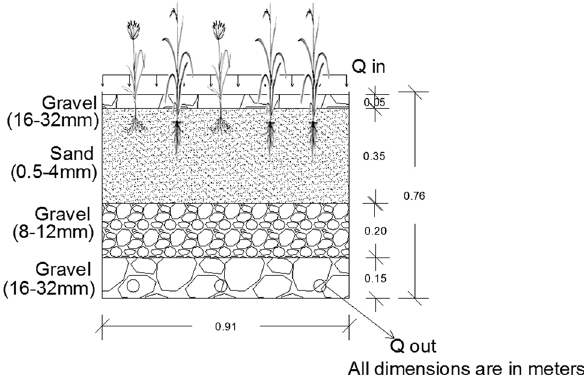
Fig. 3 Schematic representation of pilot-scale model